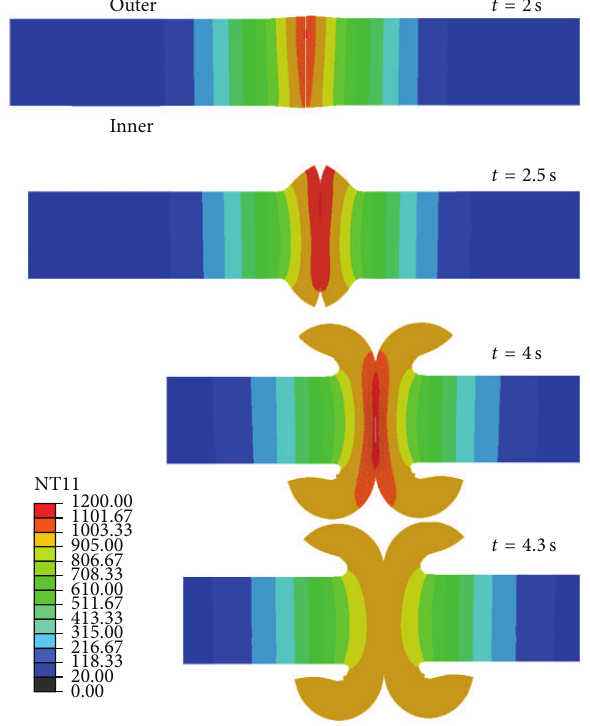
Figure 4: Temperature contours and upset variation at different welding